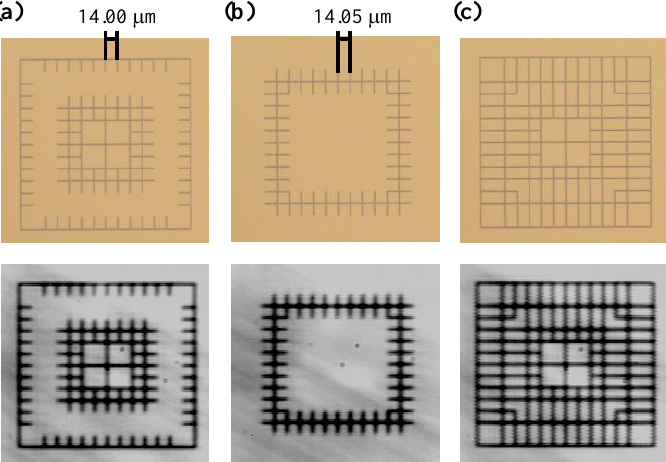
Figure 3. Design of markers dedicated for alignment: ( a ) Alignment marker formed on the upper wafer with the main scale pattern as a vernier caliper; ( b ) Alignment marker formed on lower wafer with vernier scale pattern; ( c ) Reference marker with overlapped two markers of (a) and (b). The upper and lower panel of each figure shows reflection image under illumination with visible light and transmission image under near-infrared light, respectively.